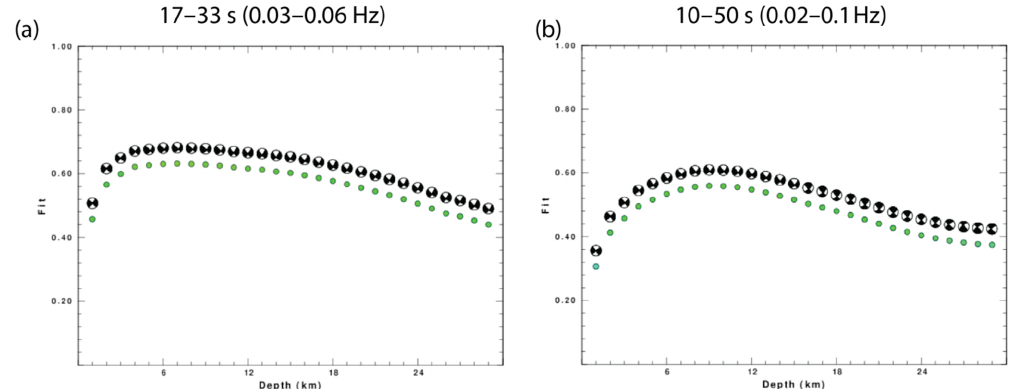
Figure 5. (a) Normalized goodness of fit versus focal depth for the earthquake shown in Fig. 4 (1 October 2013, 03:32UTC, M w = 4 . 08) using a frequency band of 0.03–0.06Hz. Perfect fit corresponds to a value of 1. For each depth, the best-fitting focal mechanism is shown. (b) Same as (a) but for the frequency band of 0.02 to